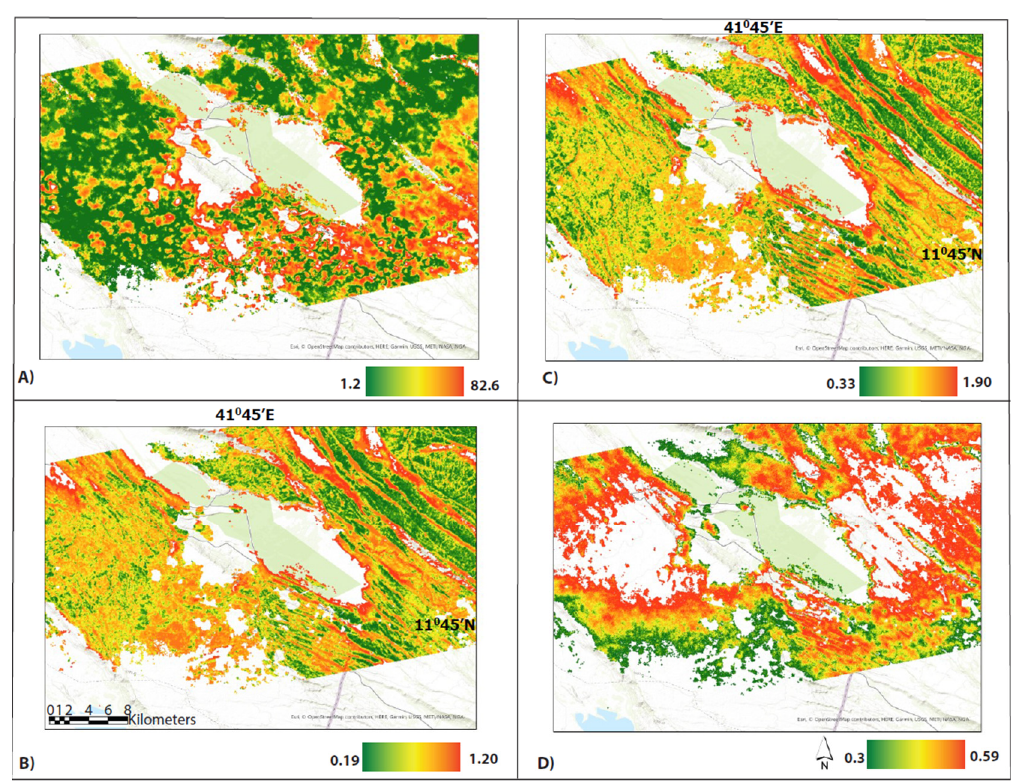
Figure 4. The quality of the InSAR results from ascending tract 257 needed to be checked using several indices: ( A ) The Root Mean Square Error (RMSE); ( B ) Height Precision (HP); ( C ) Velocity Precision (VP) and ( D ) multi-temporal interferometric